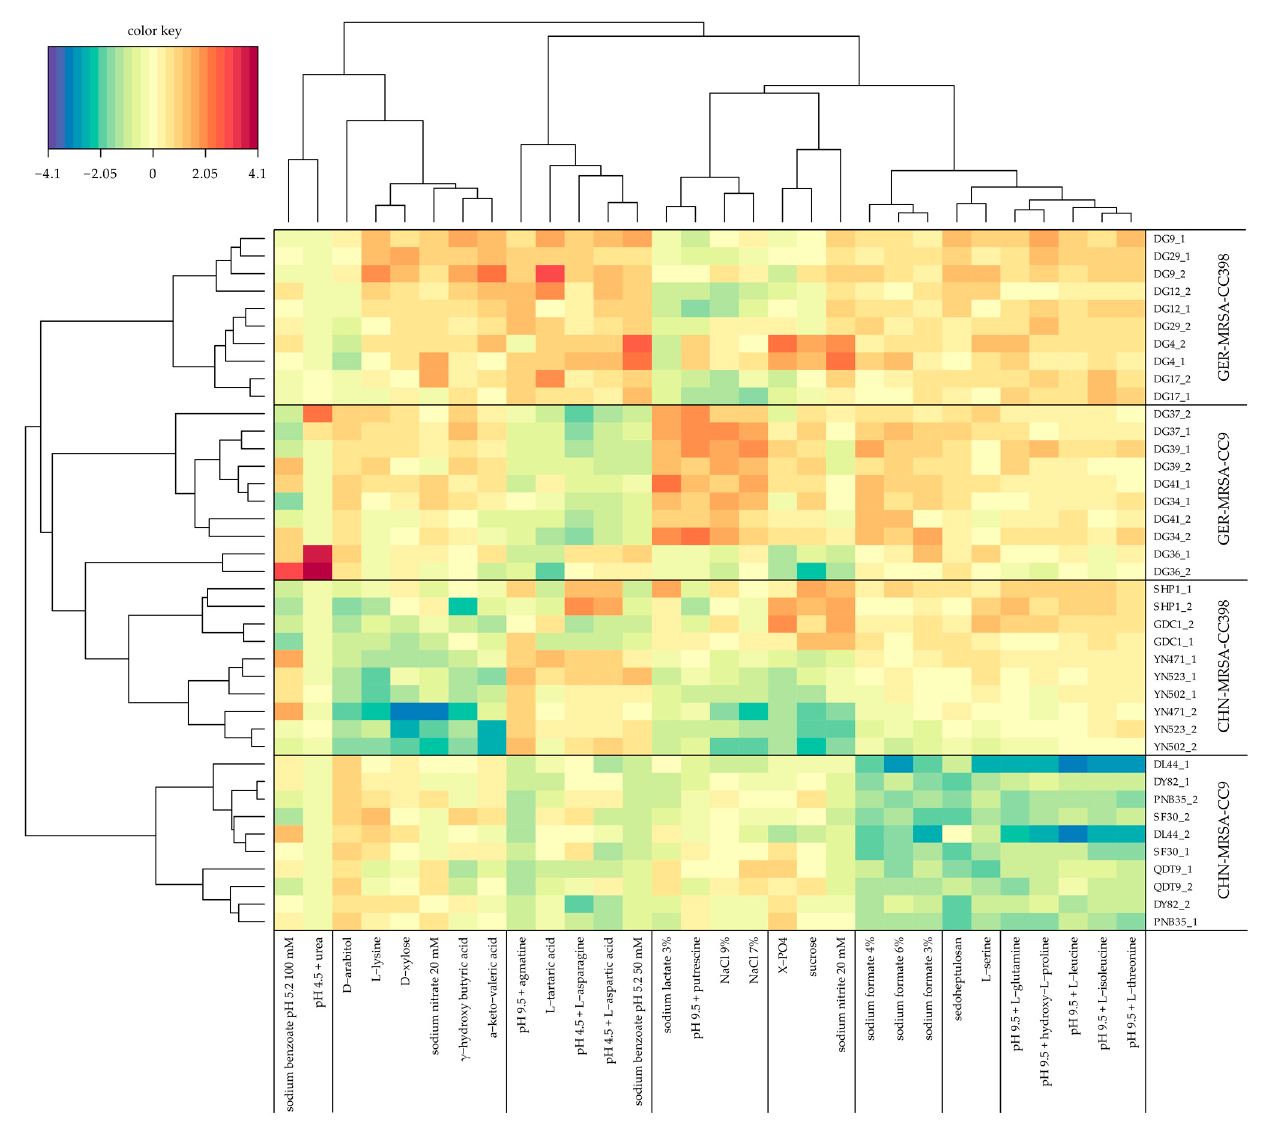
Figure 2. Heat map constructed via sPLS-DA using four components to differentiate porcine MRSA isolates from Germany and China based on CC and origin. Two independent area under the curve (AUC) values obtained after 24 h of incubation were considered for each of the isolates displayed on the right side. Based on the most remarkable differences selected nutrients are shown at the bottom. The color key mirrors the extent of metabolic substrate utilization (z-scaled) by the isolates, with red color displaying more successful and blue color less successful usage of a nutrient. The branching diagram provides classification of isolates and substrates into different groups.